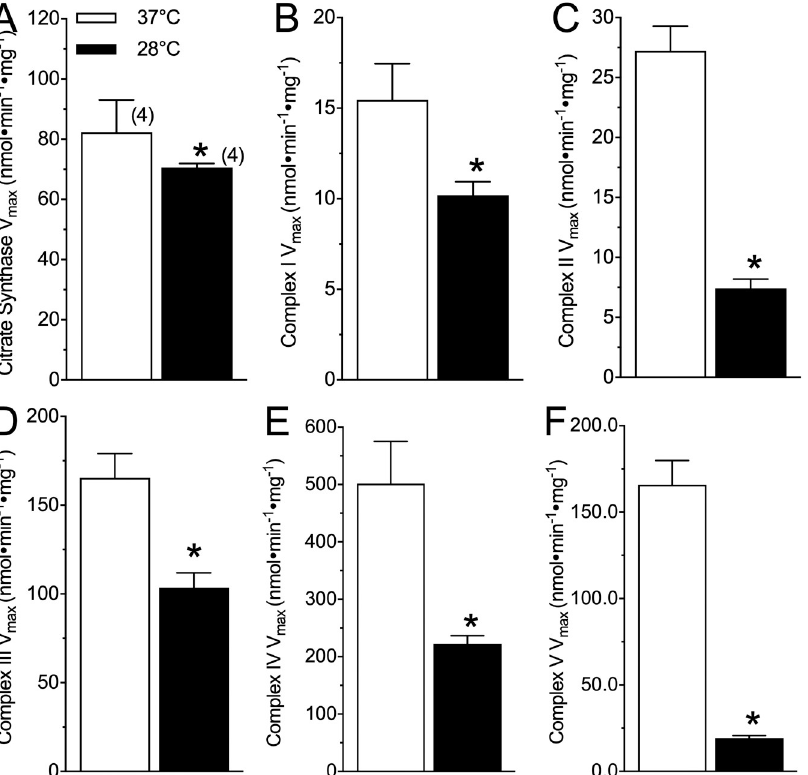
Fig 2. Complex enzyme maximum activity is not consistently altered by hypothermic experimental temperatures. (A-F) Citrate synthase (A), and complexes I (B), II (C), III (D), IV (E), and V (F) V max from homogenized whole mouse brain assayed at physiological temperature (37˚C; white bars) or a hypothermic temperature (28˚C; black bars). Data are mean ± SEM. Numbers in parenthesis indicate the number of samples assayed from individual animals. Asterisks ( � ) indicate significant differences between physiological and hypothermic temperatures (p < 0.05; see Results section for statistical tests).